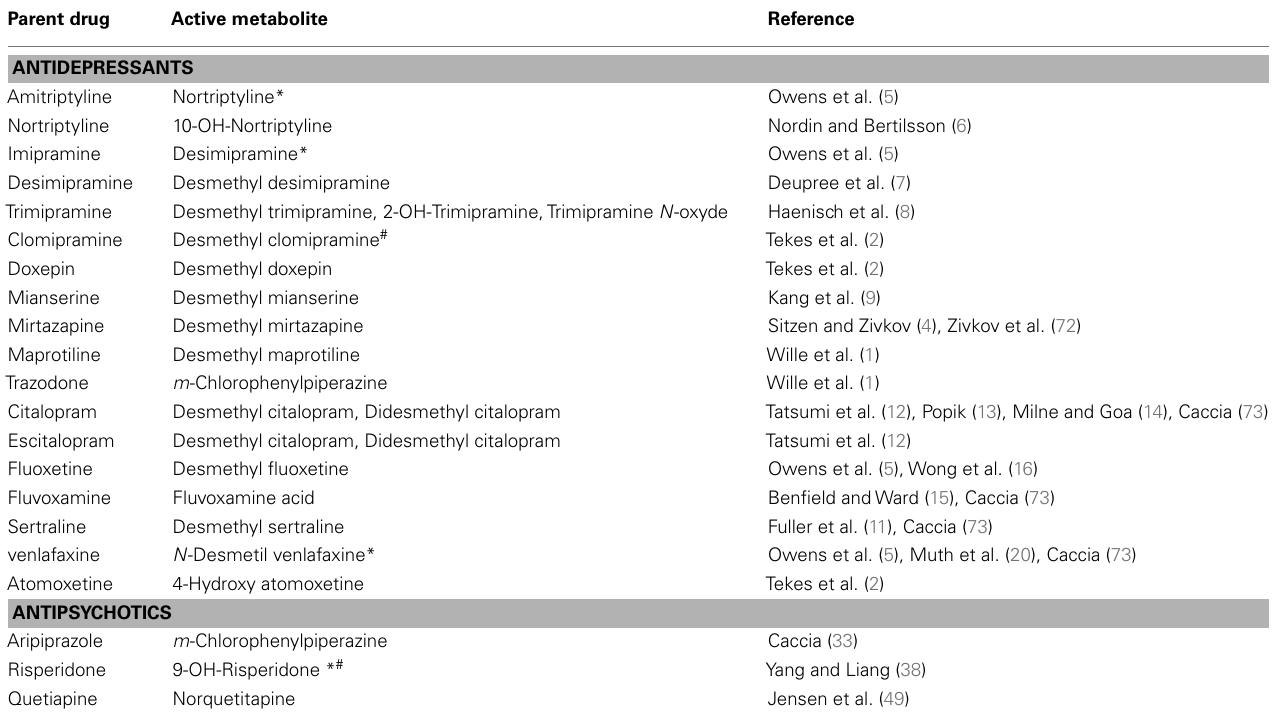
Table 1 |Active metabolites of psychotropic drugs with antidepressants